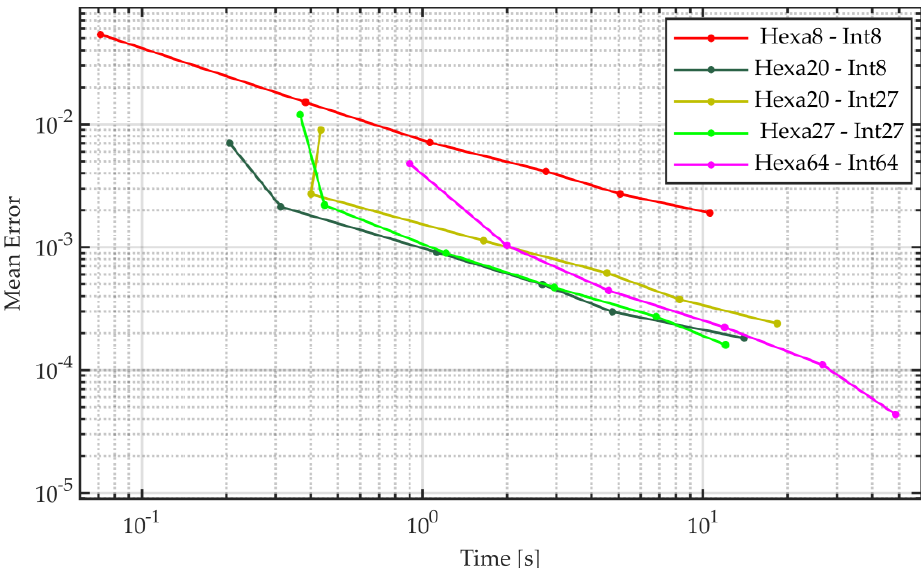
Figure 7. Convergence analysis of serendipity quadratic FE formulations as a function of the assembly time in comparison with full − order elements.